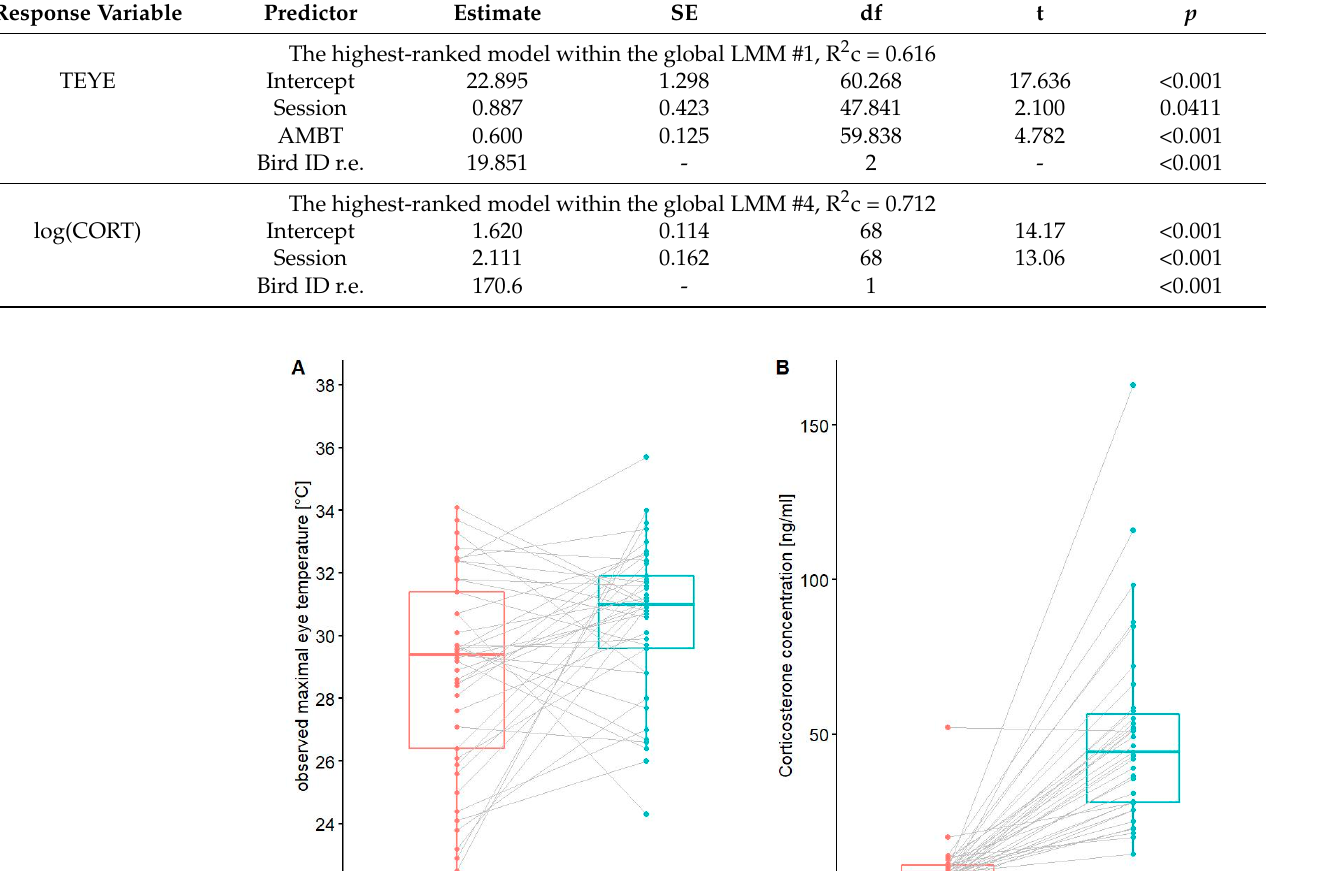
Figure 3 . Relationship between handling, stress-induced eye-region temperature, and restrain stress-induced eye-region temperature. Smooth curve fitted by local polynomial regression (loess).